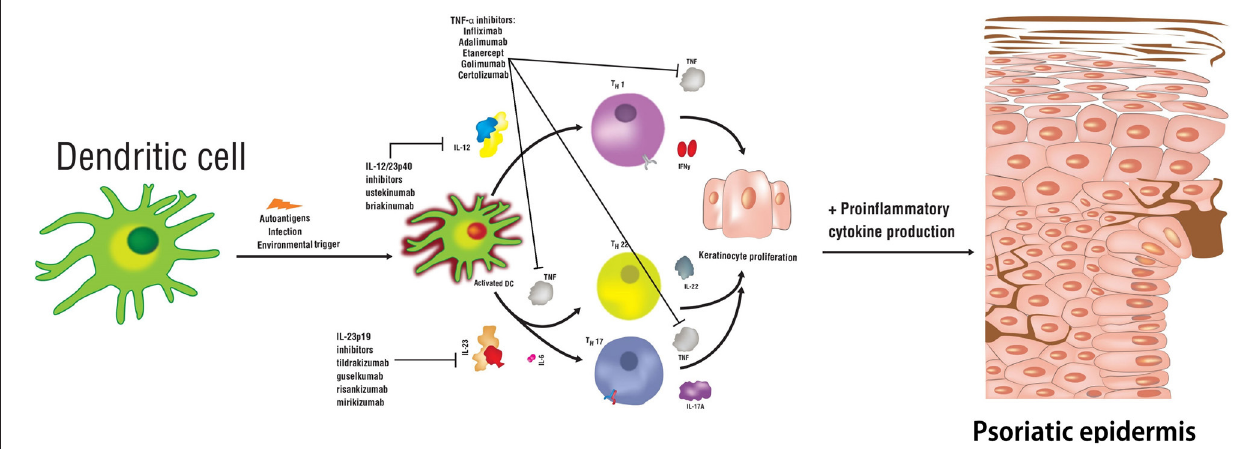
FIGURE 1 | Schematic representation of relevant cytokines and T helper cell subsets involved in the pathogenesis of psoriasis. Biologic therapies used to treat this disease are indicated along with the signaling pathways targeting specific cytokines.